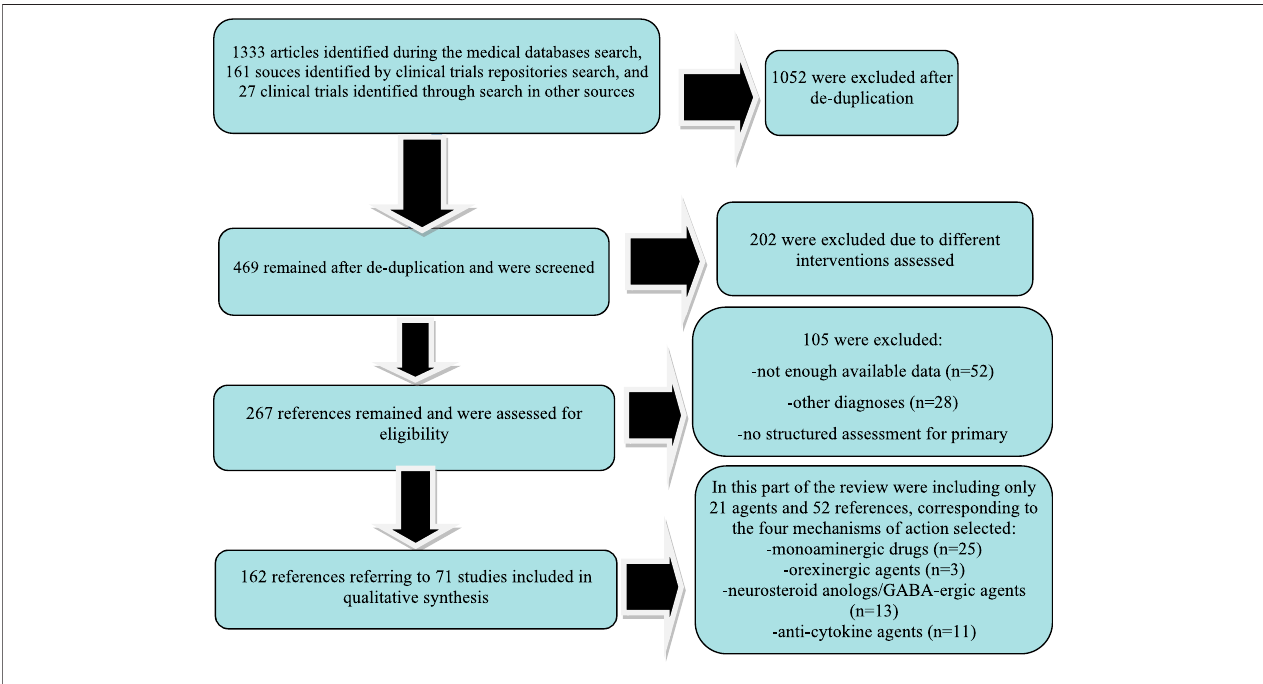
FIGURE 1 | Results of the PRISMA-based search paradigm.